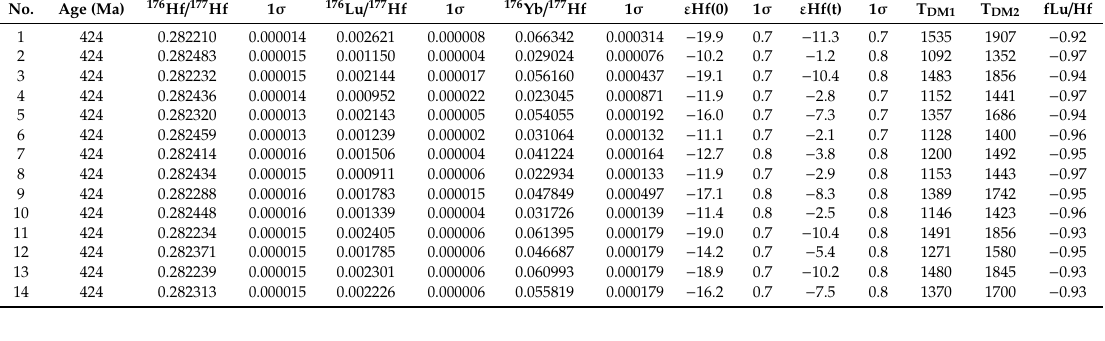
Figure 6. Zircons U–Pb concordia diagram for gabbro in Akechukesai IV mafic–ultramafic complex. Table 3. Zircon Lu-Hf isotopic compositions of gabbro in the Akechukesai IV mafic -ultramafic complex. No. Age (Ma) 176 Hf / 177 Hf